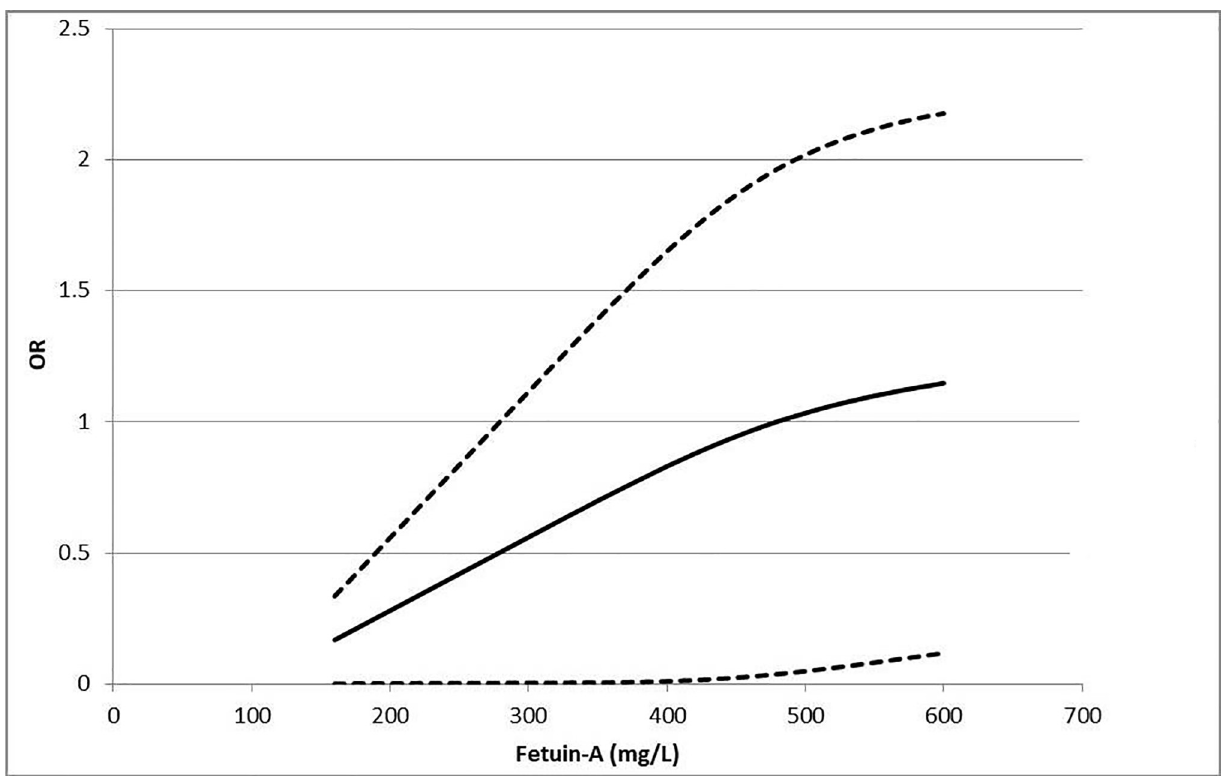
Fig 4. Non-linea dose–response relationship between the risk of MetS and fetuin-A concentrations. Odds ratio (OR;—) and the corresponding 95% CI (---) were summarized for thenon-linear dose–response relationship between fetuin-A concentrations with MetS risk. MetS, Metabolic syndrome; OR, odds ratio.